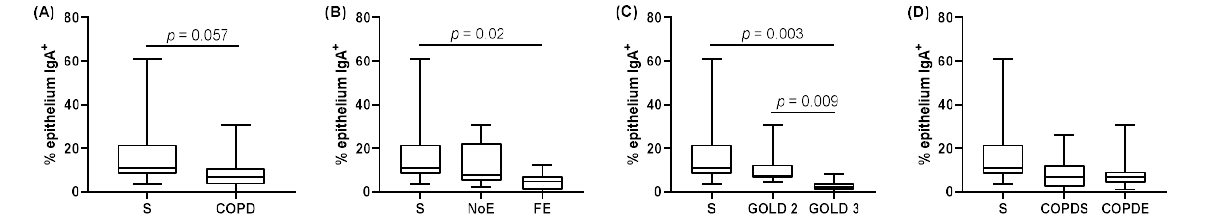
Figure 2. Quantification of IgA expression. IgA expression was compared between ( A ) COPD patients and smoking controls (S), with further detailed clinical phenotyping in COPD patients based upon ( B ) exacerbations, ( C ) airflow limitation, and ( D ) smoking status. Data presented as median ± range. Comparisons between groups were made by one-way Kruskal–Wallis followed by Dunn’s multiple comparison tests.